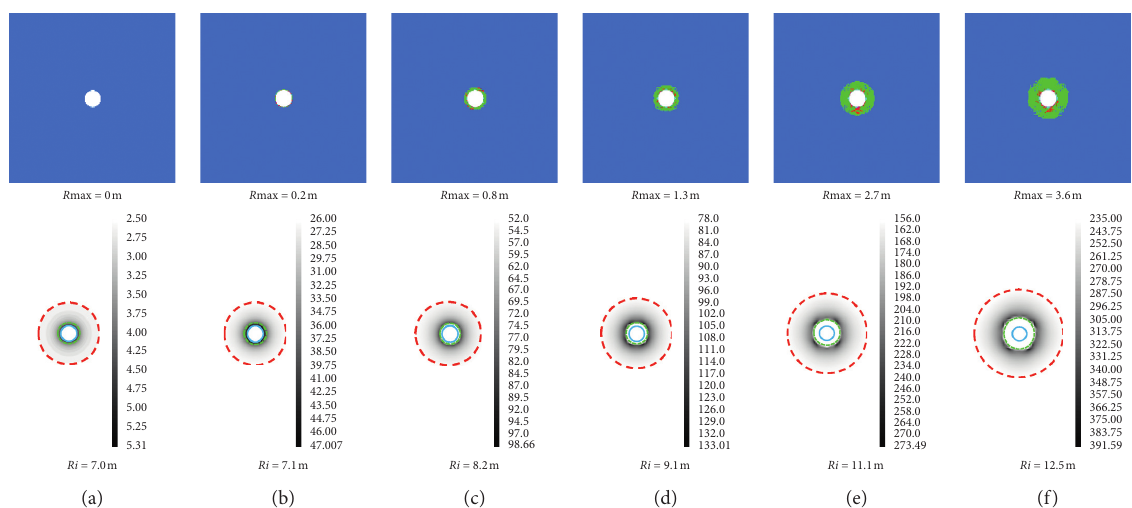
Figure 4: Plastic area of the surrounding rock of the hole in the sandy mudstone and its influence range: (a) H � 100m; (b) H � 1000m; (c) H � 2000m; (d) H � 3000m; (e) H � 6000m; (f) H � 9000m.